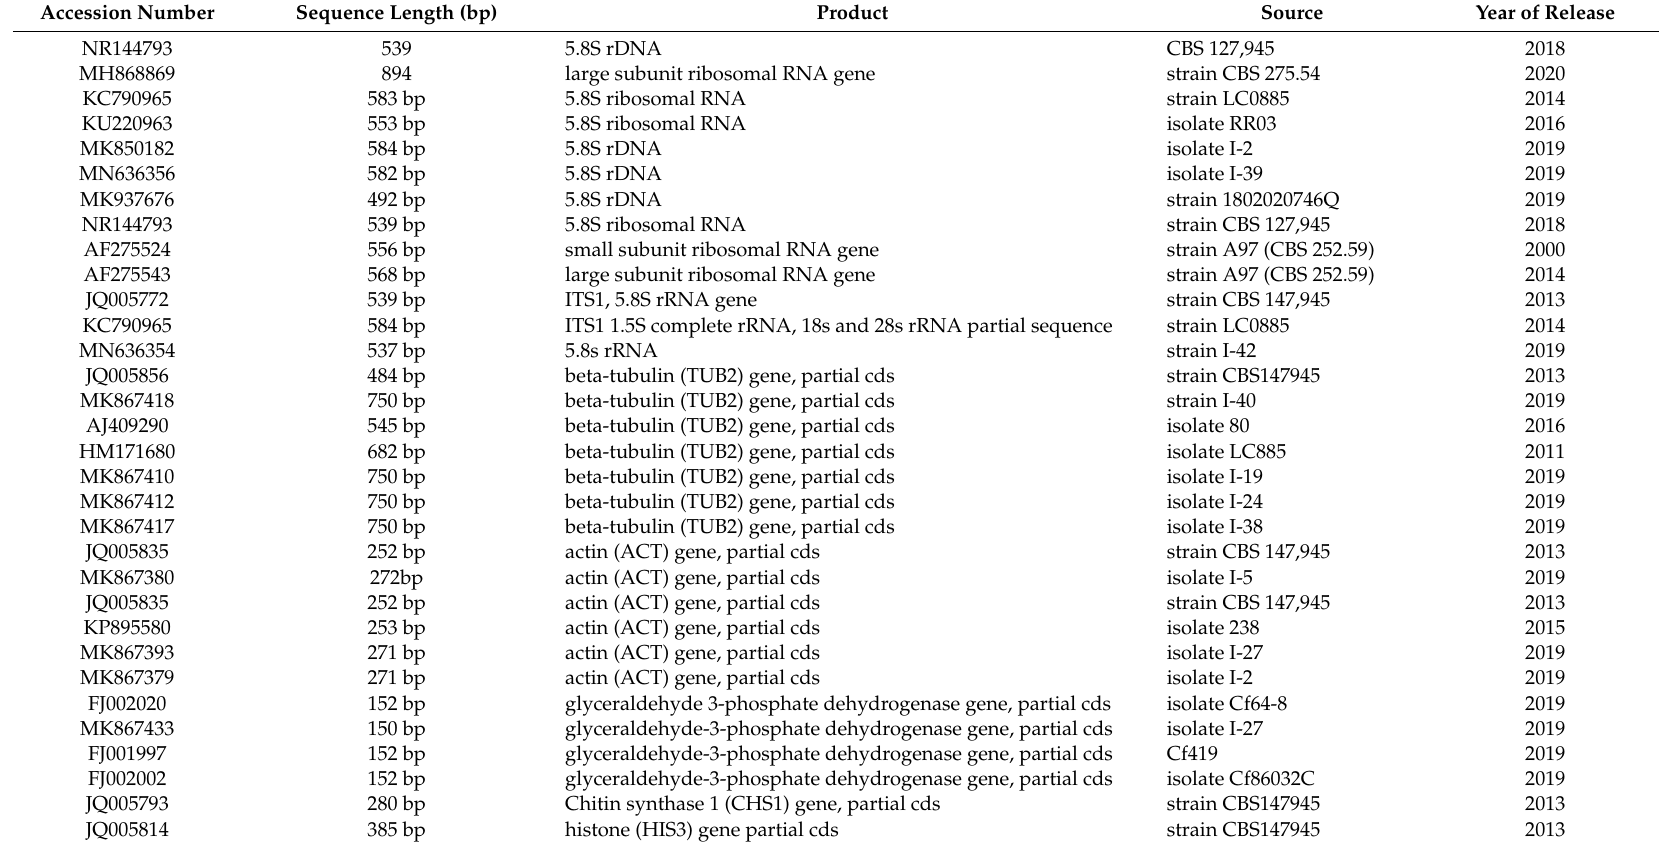
Table 1. Colletotrichum falcatum nucleotide sequences available in public domain